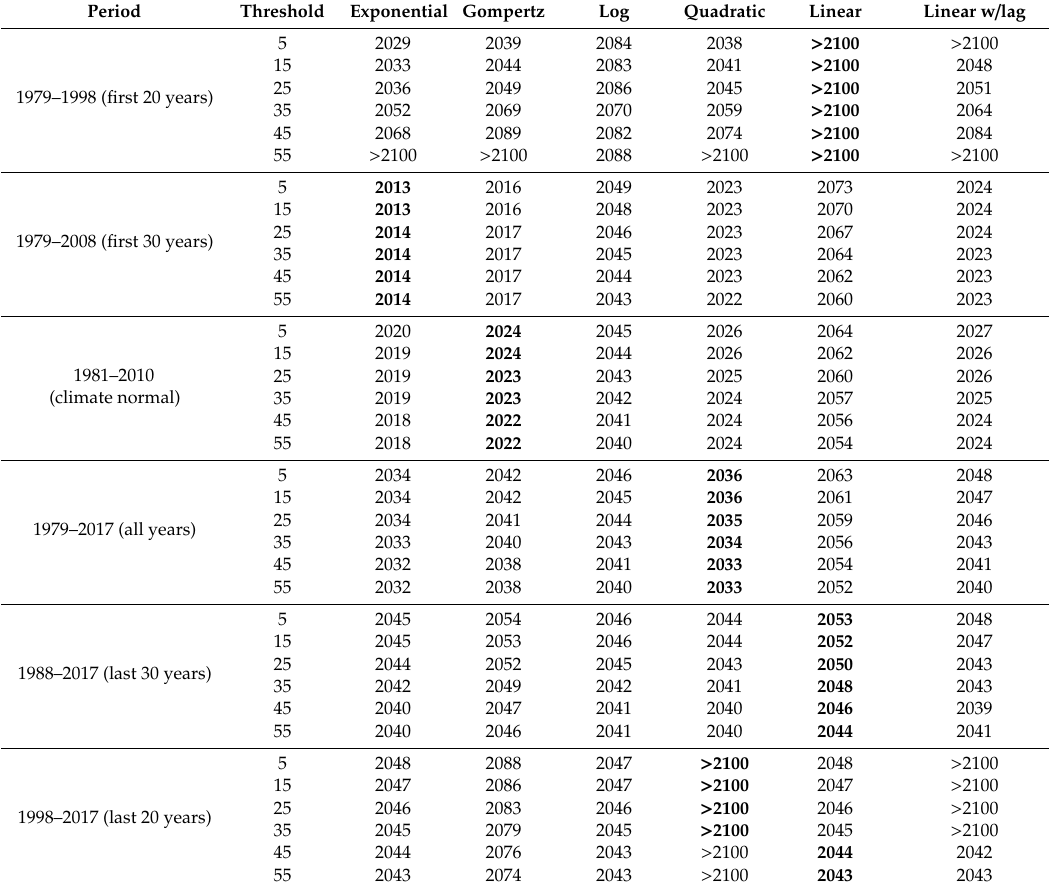
Table A2. FIASY estimates for all examined models, time domains of calibration, and thresholds. Entries in bold italics indicate the largest W-Akaike weight values, and hence optimal model, amongst models examined (see weights in Table